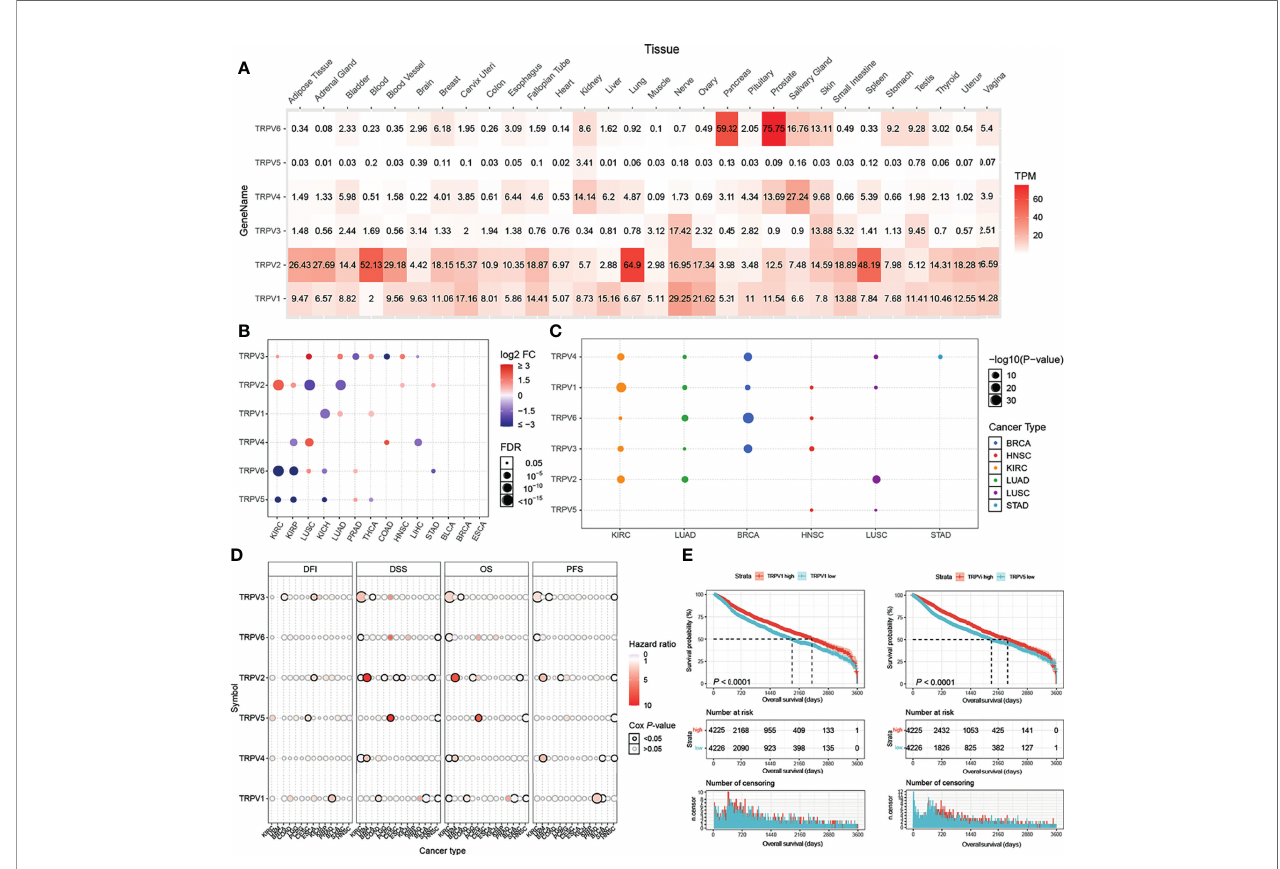
FIGURE 1 | TRPV and subtype analysis of gene expression. (A) The heat map shows the expression pro fi les of the TRPV regulators in the GTEx dataset. (B) Signi fi cant differences in mRNA expression between normal and tumors in TCGA database. (C) Changes in mRNA expression in different cancer subtypes. (D) Survival analysis of TRPV regulators. The size of the dots represents the signi fi cance of the gene ’ s in fl uence on survival for each cancer type,and the statistical signi fi cance of differences was determined by cox regression analysis. (E) TRPV1 and TRPV5 high expression contributes to the prognosis of cancer. All the signi fi cant differential expressed genes are shown in the fi